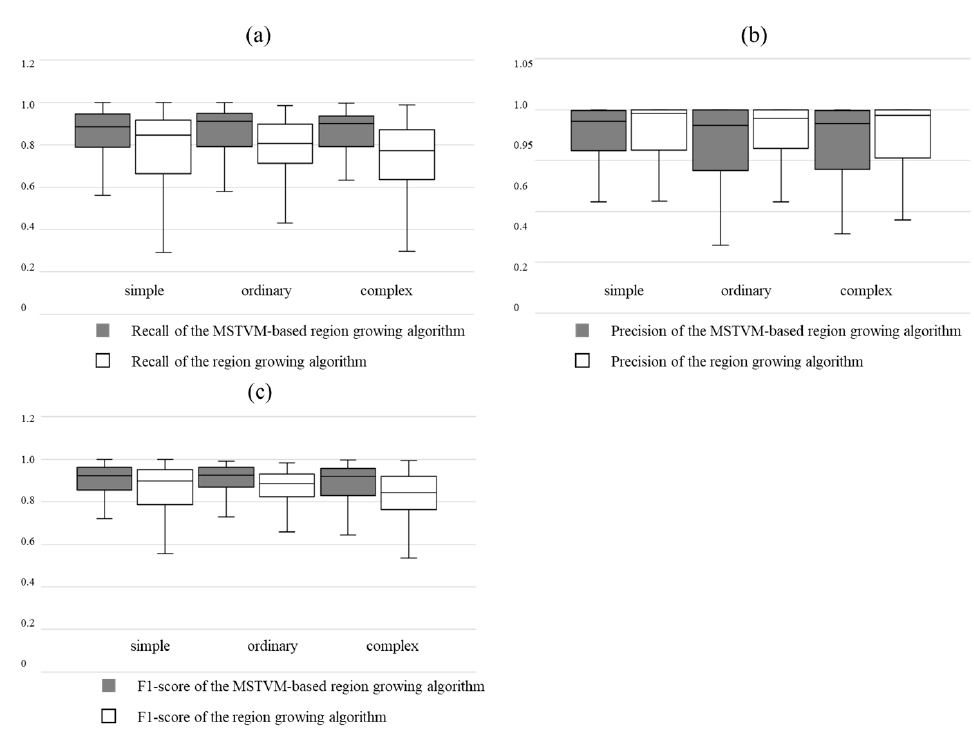
Figure 6. Box plots of the accuracy indicators between region-growing algorithm and MSTVM-based